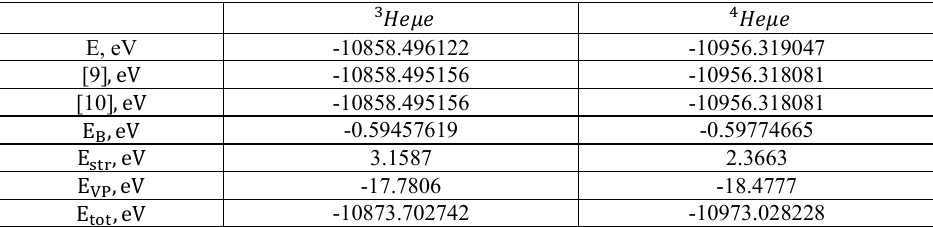
Table 2. Numerical values of total energy of the ground state, corrections to the structure of the nucleus, relativistic correction, and correction to the vacuum